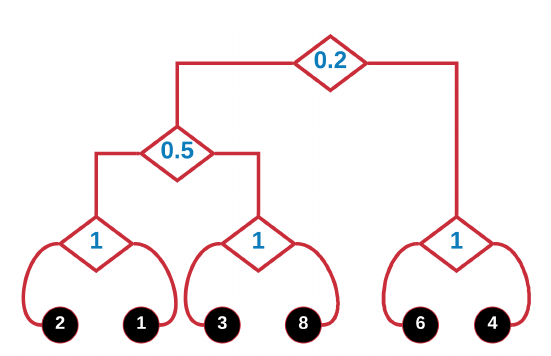
Figure 11. Example of Network‘s Dendrogram among those nodes which are descending from it. Con- sider a dendrogram in Equation 1, where Den is the representation of network and e k represents the number of those links which are connecting internal nodes k in Den . The likelihood of network can be estimated as in Equation